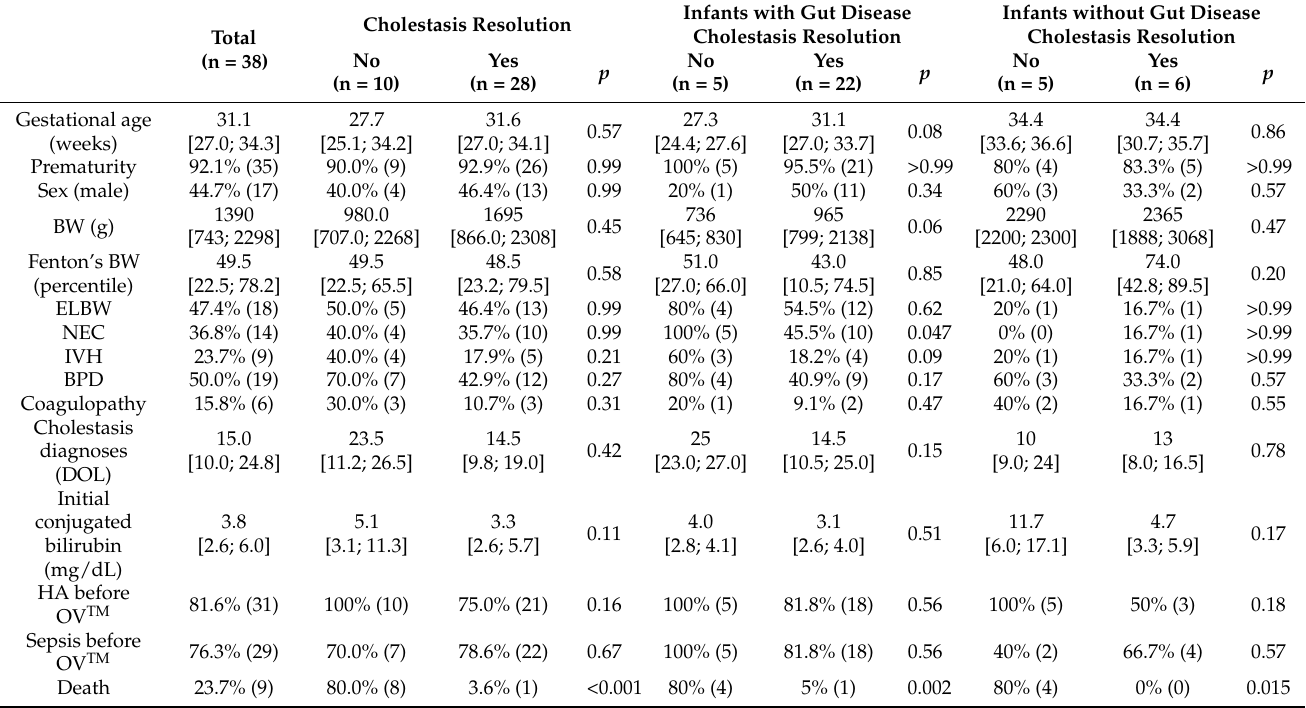
Table 1. Neonatal and clinical characteristics of the